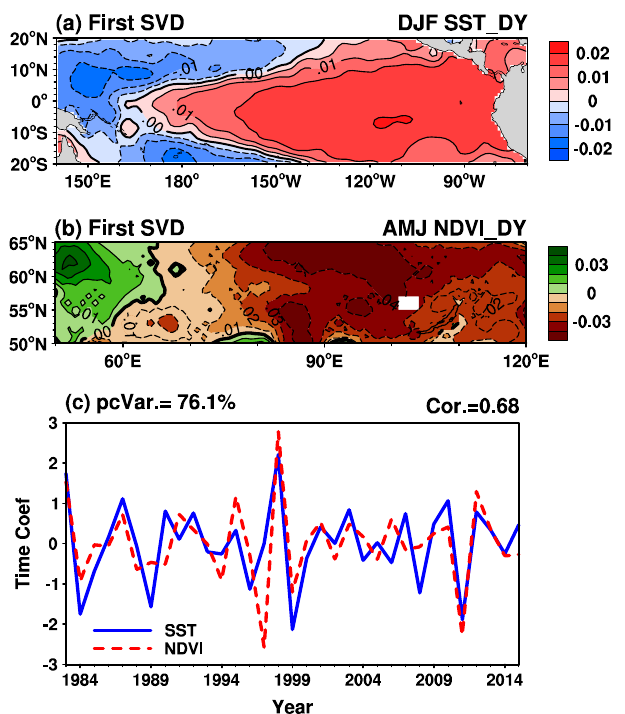
Figure 5. Spatial patterns for the first paired mode of the DY of ( a ) winter (December–January–February (DJF)) sea surface temperature (SST, tropical Pacific) and ( b ) spring (April–May–June (AMJ)) NDVIEA via SVD analysis during 1983–2015. ( c ) The corresponding normalized time series of the expansion coe ffi cients for the paired mode; their correlation coe ffi cient is shown above the top right-hand corner, and the variance explained by the first mode is shown above the top left-hand corner.